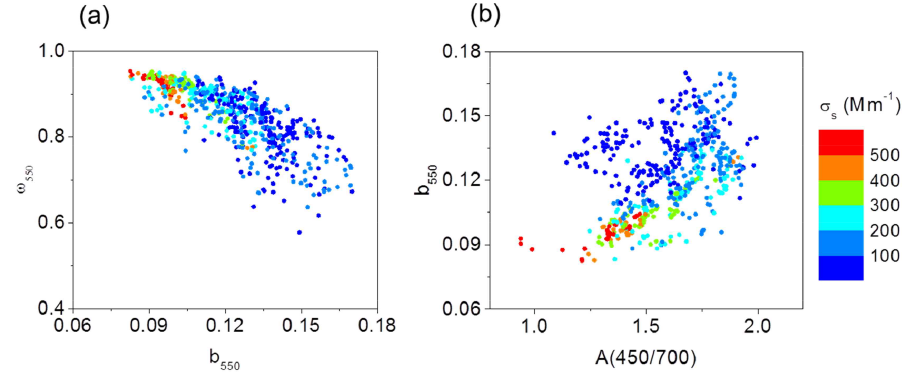
Figure 5. Scatter plots of (a) b 550 versus ω 550 and (b) Å (450 / 700) versus b 550 as a function of σ s , 550 . Table 2. Comparison of PM mass, chemical components, and intensive optical properties during long-range transported (LRT) haze and Asian dust episodes observed at Daejeon, South Korea, during January 2014.